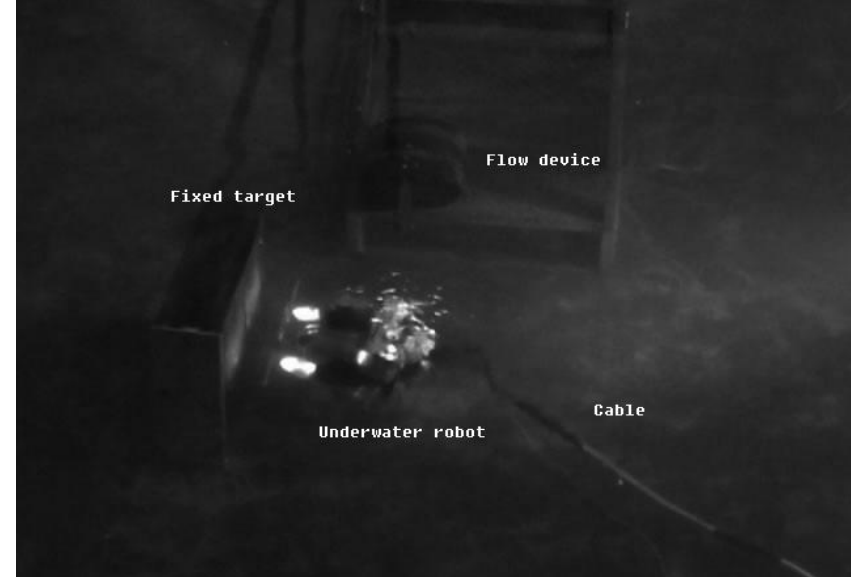
Fig. 4. Experiment of underwater